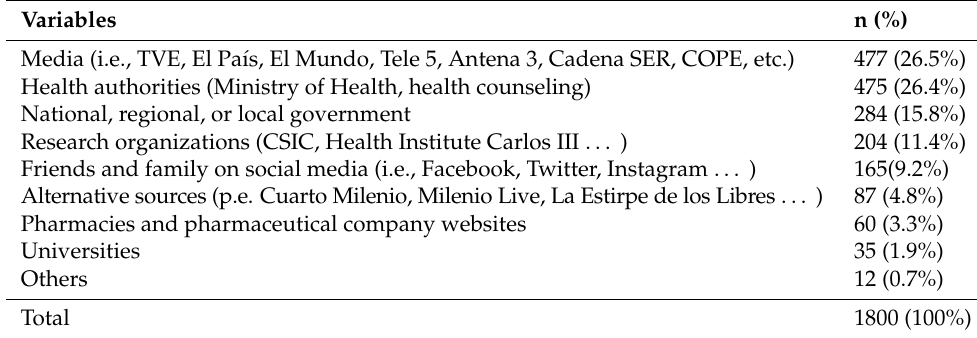
Table 3. The most important sources of information on COVID-19 during the last 12